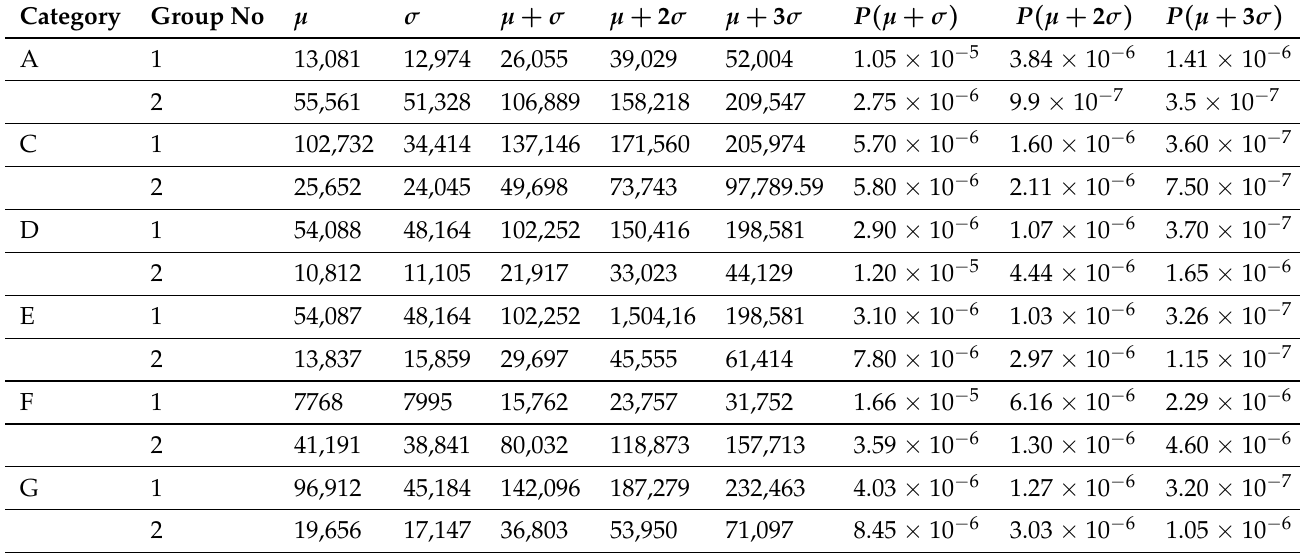
Table 17. Optimization of total medical benefit for each Category A,B,C,D,E,F and G. Category